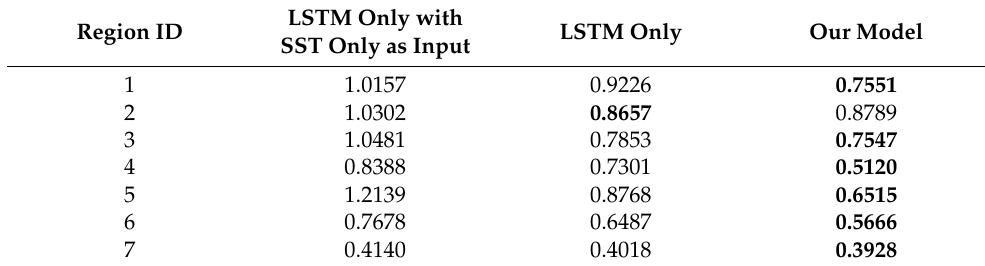
Table 5. Comparison of RMSE between different models.